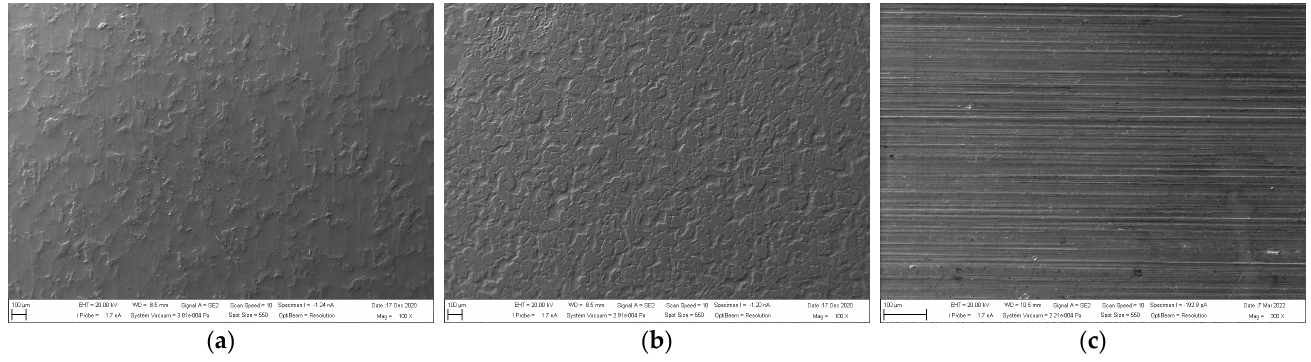
Figure 5. Appearance of materials treated with adhesion promoter: ( a ) DC, ( b ) TL and ( c ) Al.